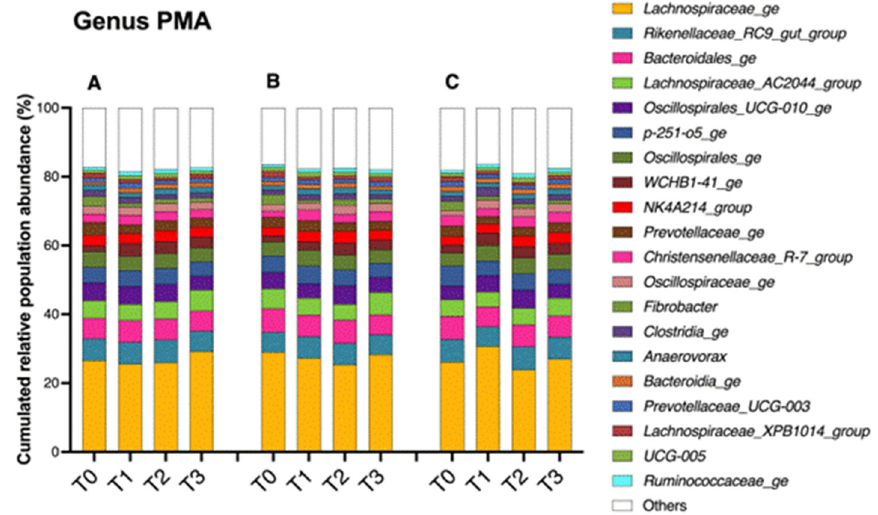
Figure 4. Changes in the bacterial populations of the fecal content assessed by 16S V1–V3